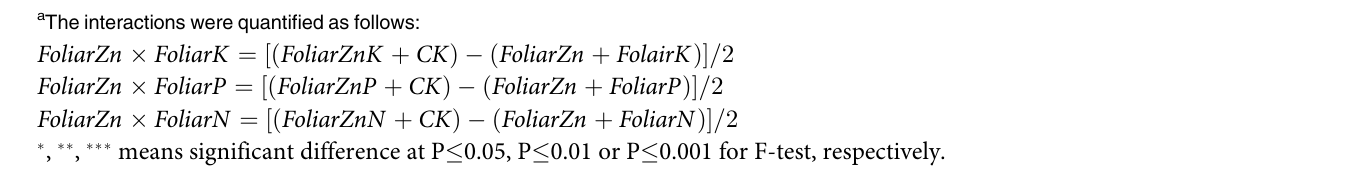
FoliarZn (cid:2) FoliarK ¼ ½ð FoliarZnK þ CK Þ (cid:0) ð FoliarZn þ FolairK Þ(cid:138) = 2 FoliarZn (cid:2) FoliarP ¼ ½ð FoliarZnP þ CK Þ (cid:0) ð FoliarZn þ FoliarP Þ(cid:138) = 2 FoliarZn (cid:2) FoliarN ¼ ½ð FoliarZnN þ CK Þ (cid:0) ð FoliarZn þ FoliarN Þ(cid:138) = 2 (cid:3) , (cid:3)(cid:3) , (cid:3)(cid:3)(cid:3) means significant difference at P (cid:20) 0.05, P (cid:20) 0.01 or P (cid:20) 0.001 for F-test,